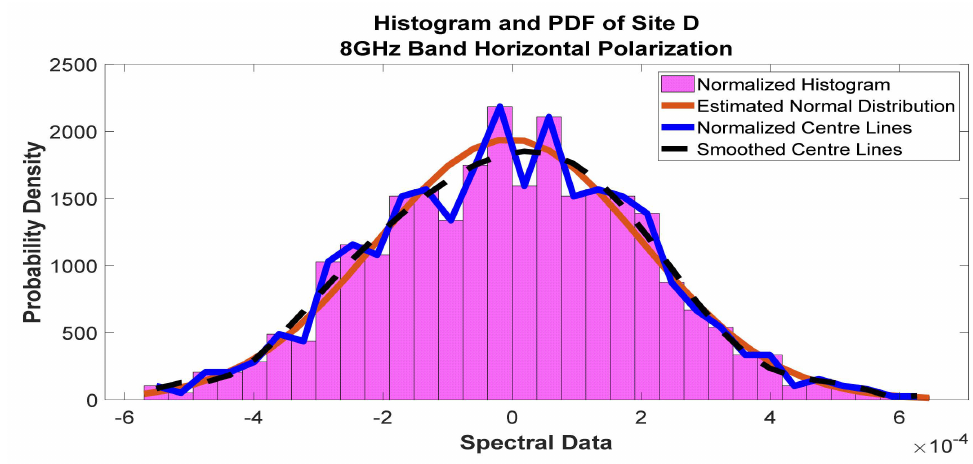
Figure 30. Histogram and PDF of the frequency scan for site D at 8 GHz horizontal polarization.